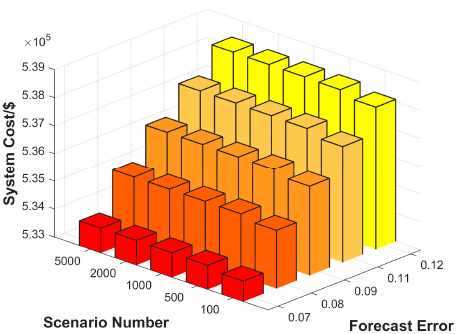
Figure 7. Objectives with different values of scenario number and wind power forecast errors.